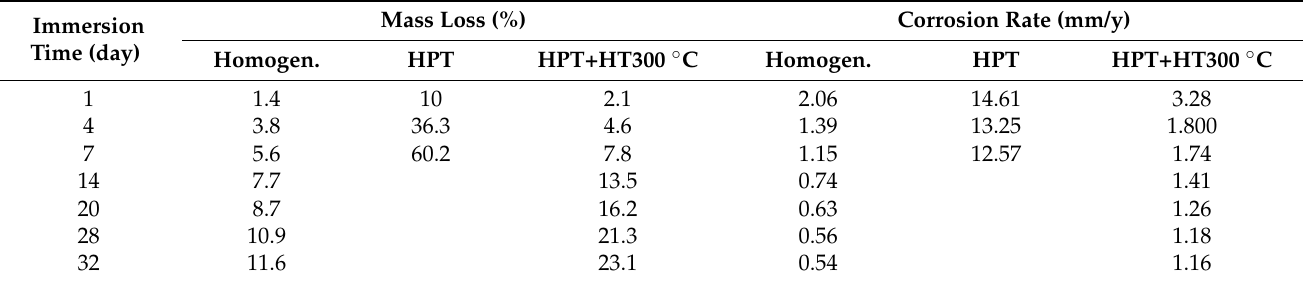
( f ) Figure 3. Surface structure of the Mg ‐ 1Zn ‐ 0.2Ca alloy samples: ( a , b ) in the homogenized state, ( c , d ) after HPT, ( e , f ) after HPT and additional HT at 300 °C, after 1 day of exposure in Ringer’s solution.